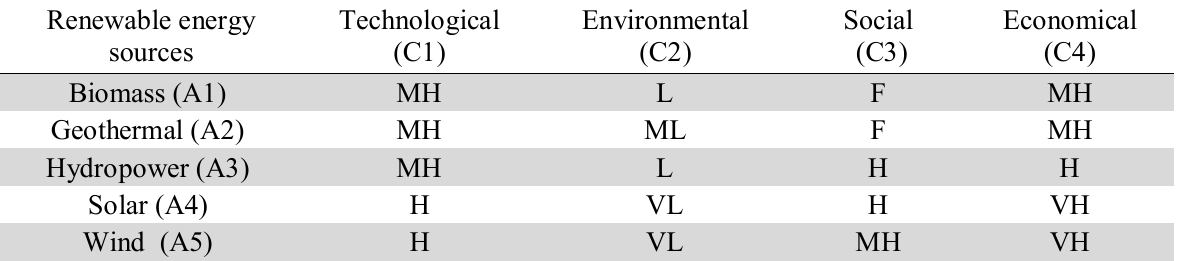
Performance rating of five renewable energy sources